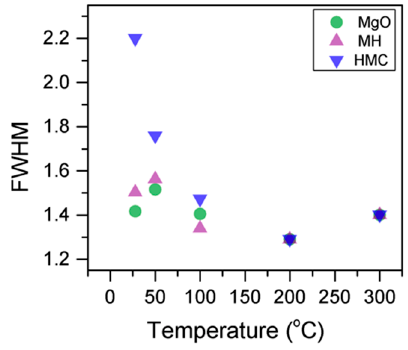
Figure 3. Evolution of the O1s FWHM as the temperature increases.